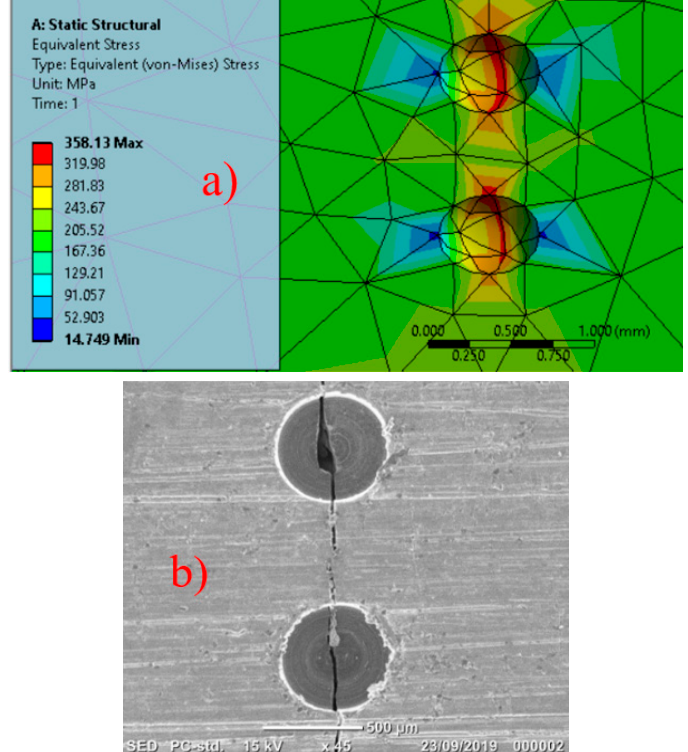
Figure 13. ( a ) Stress distribution for two pits in transverse direction and 130 μ m of total displacement; ( b ) fracture on two pits in transverse direction.